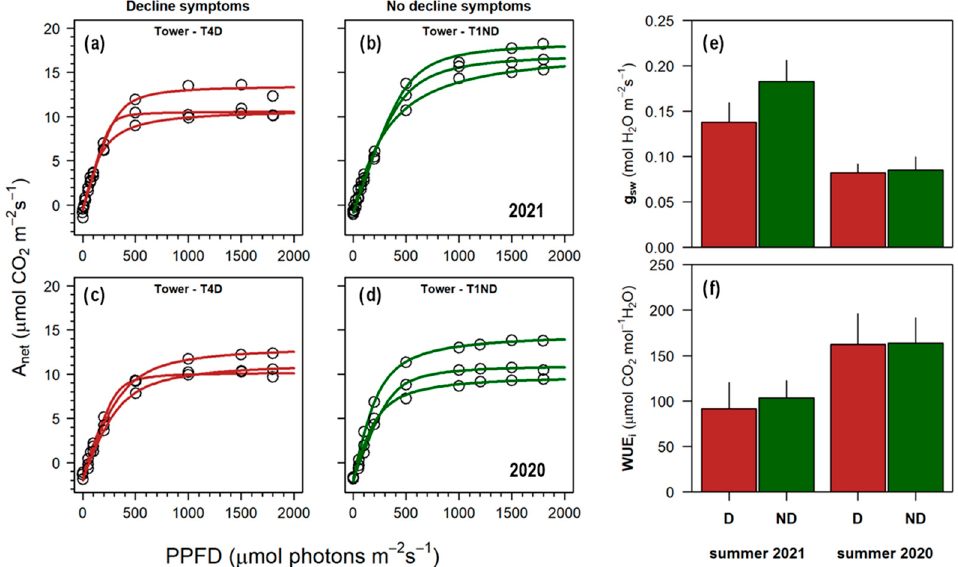
Figure 11. Ecophysiological responses of declining (D) and non-declining (ND) Q. frainetto trees of the San Paolo Albanese forest stand site. Panels ( a – d ) present the net photosynthesis curve (An, µmolCO 2 m − 2 s − 1 ), while panels ( e , f ) show the average values of stomatal conductance (gsw, mmolH 2 O m − 2 s − 1 ) and intrinsic water use efficiency (WUEi, µmolCO 2 mmol − 1 H 2 O) measured in the summers of 2020 and 2021. PPFD represents the photosynthetic photon flux density (µmol photons m − 2 s − 1 ). The black vertical bar represents the 1st deviation standard.